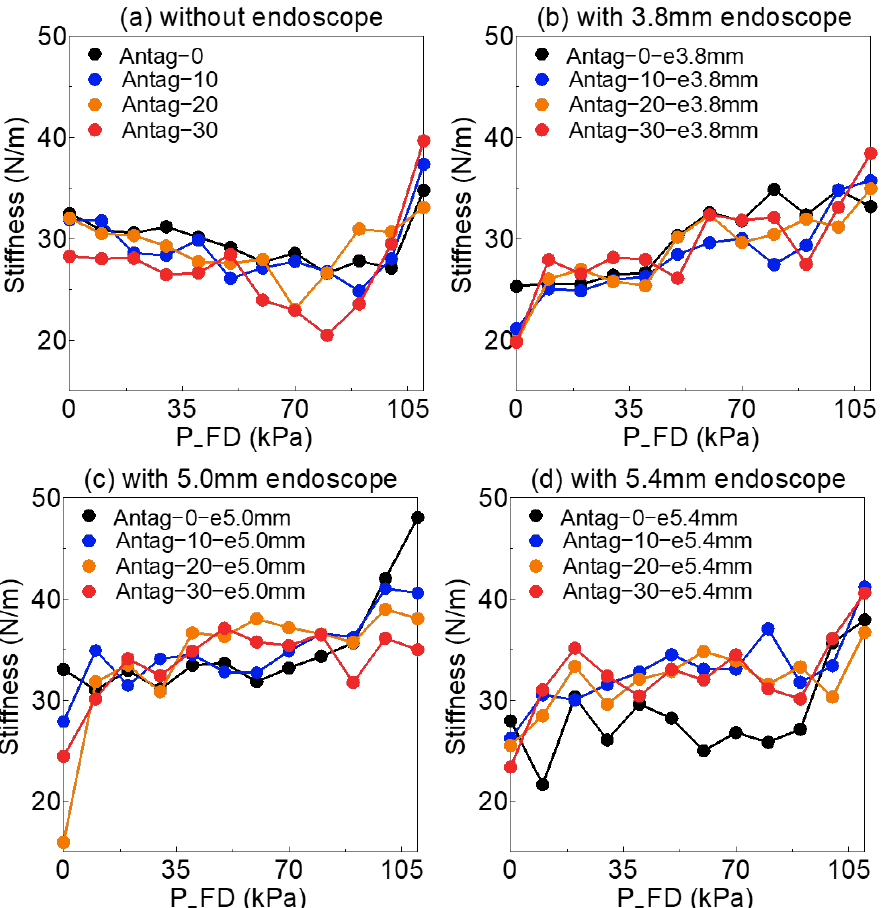
Figure 5. The variation of soft actuator’s stiffness under different sets of FU air pressure and FD air pressure ( a ) without endoscope: without inserting endoscope into soft actuator for experiment, ( b ) with 3.8 mm endoscope: inserting 3.8 mm endoscope into soft actuator for experiment, ( c ) with 5.0 mm endoscope: inserting 5.0 mm endoscope into soft actuator for experiment, ( d ) with 5.4 mm endoscope: inserting 5.4 mm endoscope into soft actuator for experiment.